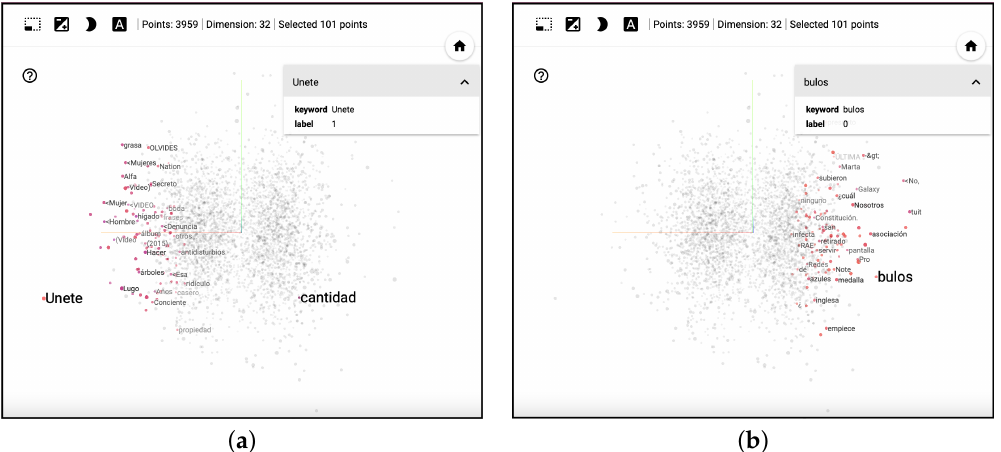
Figure 6. Visualization of FNS and nFNS keywords in the labelled embedding space. ( a ) Label 1. ( b ) Label